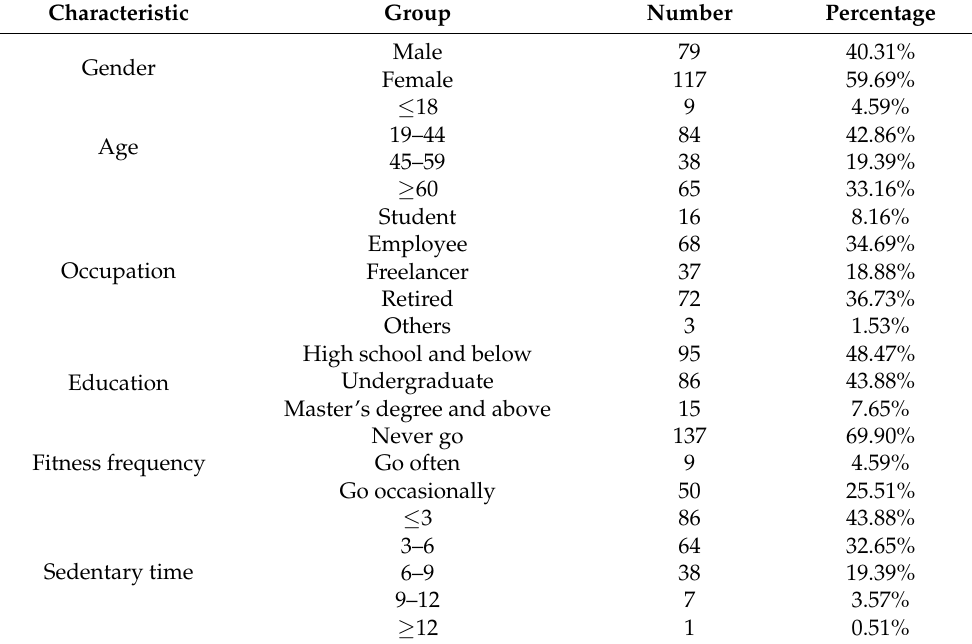
Figure 2. The location of the survey site in Wuhan. ( A ) Remote sensing image of Wuhan City; ( B ) remote sensing image map of the area within the third ring road in Wuhan; ( C ) Hongshan Square; ( D ) Shouyi Square; ( E ) Xibeihu Square. Table 1. Socio-economic characteristics of visitors to the